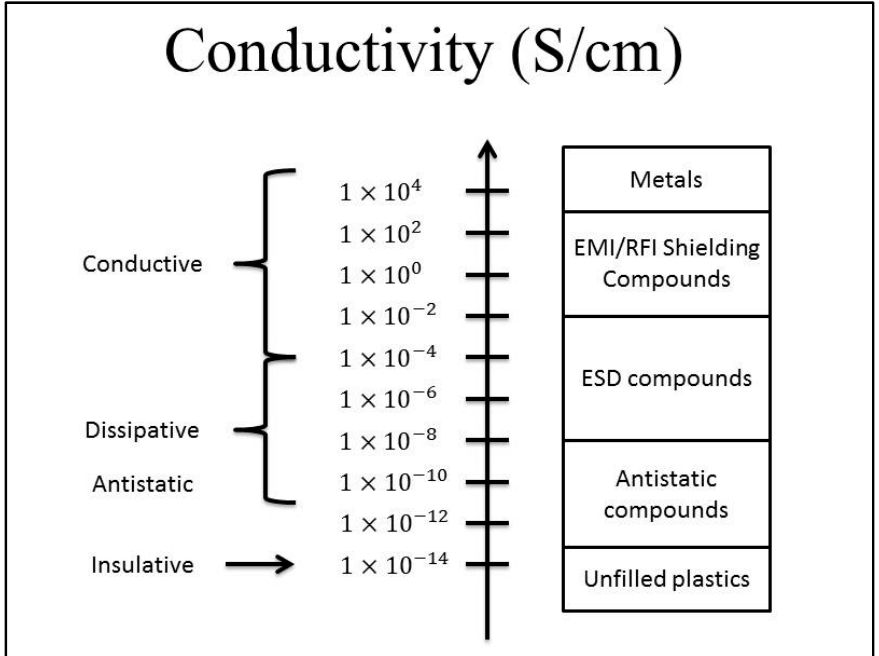
Figure 7. Conductivity ranges for different applications [78,79].